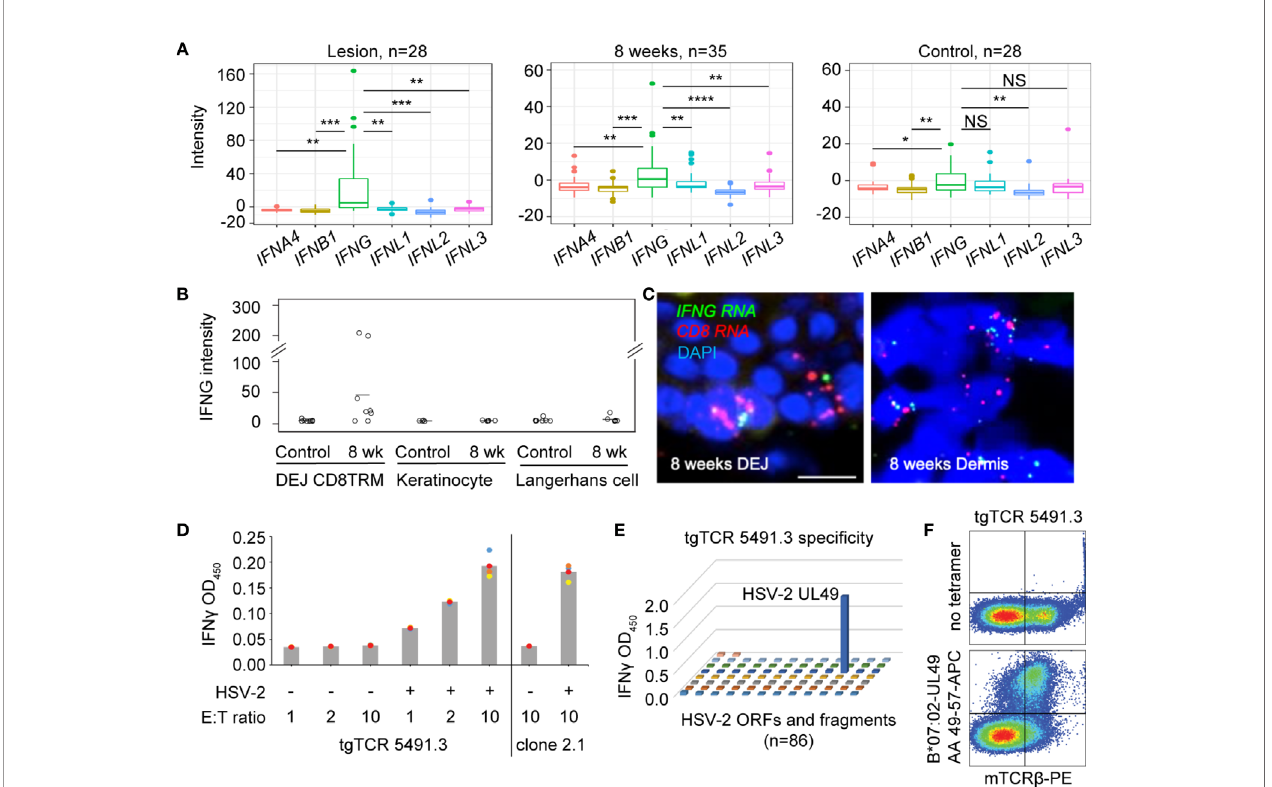
FIGURE 3 | Expression of IFNG predominates in HSV-affected skin during and after viral recurrence. (A) Transcriptional analysis showing expression levels of IFN4A, IFNB1 (type I IFN), IFNG (type II IFN), IFNL1, IFNL2 and IFNL3 (type III IFN) gene in skin biopsies of n = 28 at the time of HSV-2 lesion, n = 35 at the time of 8-week post-healing, and n = 28 matched contralateral normal controls. In box plots, the center line is the median, box edges show upper and lower quartiles, whiskers represent the range and dots indicate outliers. *p < 0.05, **p < 0.01, ***p < 0.001, ****p < 0.0001, NS, not signi fi cant; student t test. (B) IFNG gene expression in DEJ CD8TRM (n = 8), keratinocytes (n = 5) and Langerhans cells (n = 7) laser microdissected from skin biopsies obtained at 8-week post-healing and their matched normal control skin, pro fi led by whole genome array. (C) RNA FISH images depicting co-expression of IFNG and CD8 mRNA transcript in cells (nuclei stained with DAPI) at the DEJ and in the dermis of an 8 weeks post-healing skin biopsy. Scale bars, 20 µm. (D) Recognition of autologous HSV-2-infected EBV-LCL by reconstructed transgenic TCR (tgTCR) 5491.3 reporter cells. Effectors and APC were co-incubated at indicated ratios for 24 hours. T cell activation as detected by IFN- g release. HSV-2-speci fi c CD8 T cell clone 2.1 as positive control. All combinations of effector cells and APC were run in quadruplicate. Each dot an individual value and bars as mean values. (E) Representative raw data from HSV-2 proteome-wide screen. Cos-7 cells were co-transfected with HLA B*07:02 cDNA and 86 individual HSV-2 genes or fragments. tgTCR5491.3 reporter cells were added for 24 h and IFN- g release measured by ELISA. (F) tgTCR5491.3 reporter cells stained with anti-mouse TCR beta and tetrameric HLA B*07:02-HSV-2 UL49 AA 49-57 or no